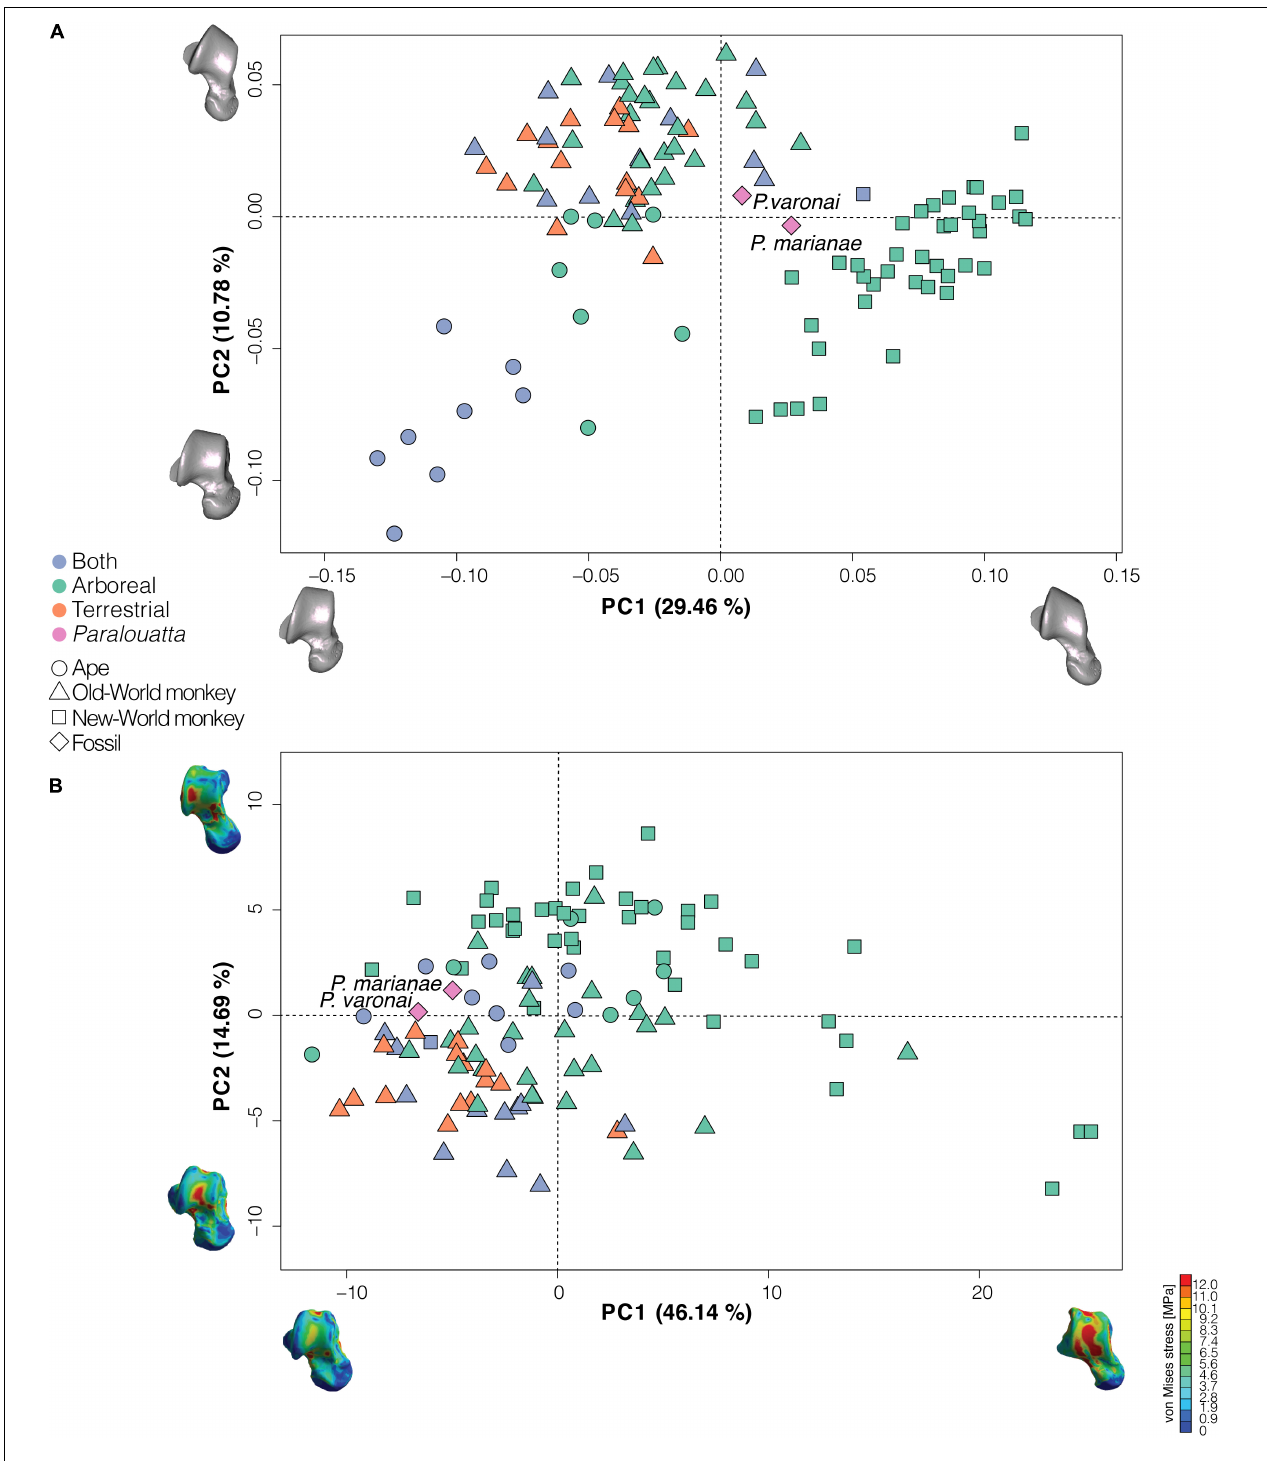
FIGURE 4 | (A) Principal component analysis (PCA) of the talar shape variables (only the two first PCs are shown). The models closest to the mean shape (i.e., Cercopithecus mitis ) was warped to match the multivariate mean using the thin plate spline method. The obtained average model was then warped to represent the variation along the two plotted PC axes in both analyses (mag = 2); (B) Principal component analysis (PCA) of the stress data (i.e., intervals) obtained from the finite element simulations. The models located at the extremes of the PC axes correspond to the individuals showing the maximum or minimum values along the two first